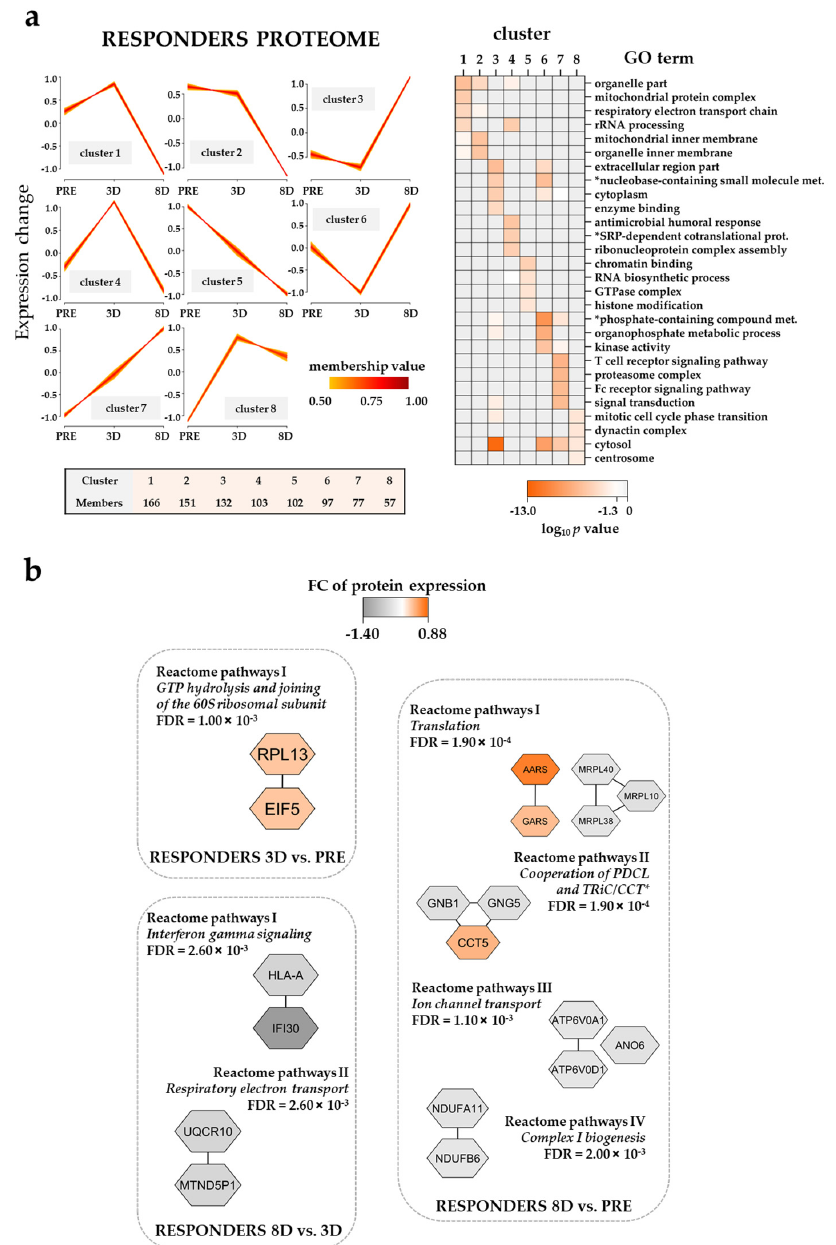
Figure 4. Protein expression profiles of responders before treatment (PRE) and after two days of ATRA treatment (3D) followed by ATRA–VP–TP treatment for five additional days (8D): ( a ) standard fuzzy c-means clustering of the protein expression profiles were performed by the online VSClust application (see Materials and Methods). The plots for the eight proteome clusters, adapted from the original VSClust plots, show only features confidently assigned with a minimum membership value of 0.5. The number of members for each proteome cluster is shown below the plots. The GO term enrichment analysis of each of the proteome clusters is shown as a heatmap on the right side. * Full names of abbreviated GO terms are nucleobase-containing small molecule metabolic process, SRP-dependent cotranslational protein targeting to membrane, phosphate-containing compound metabolic process and telomere maintenance via semi-conservative replication; ( b ) Reactome term enrichment of the regulated proteins identified in the differently temporal pair-wise comparisons was performed using the STRING app (1.6.0) in Cytoscape. The protein nodes are colored according to the corresponding 3D/PRE, 8D/PRE and 8D/3D FCs.